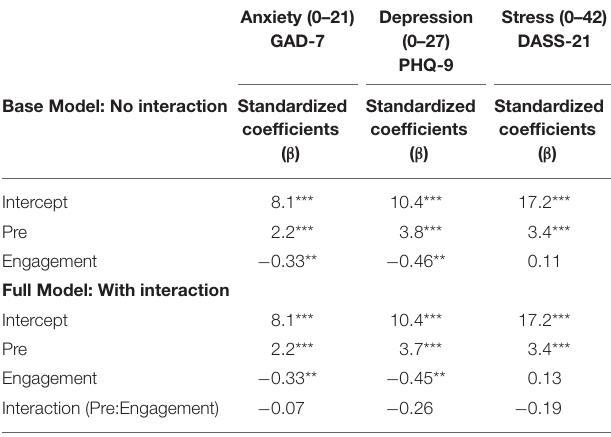
TABLE 4 | Tobit regression models quantifying the effect of pre-intervention values and engagement with Vitalk as predictors of post-intervention anxiety, depression and stress